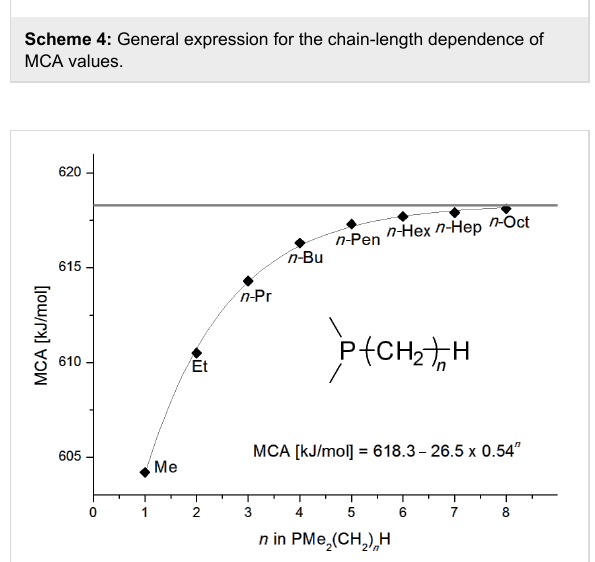
Figure 3: MCA values of monosubstituted phosphanes of general formula Me 2 P(CH 2 ) n H ( n = 1–8, in kJ/mol).